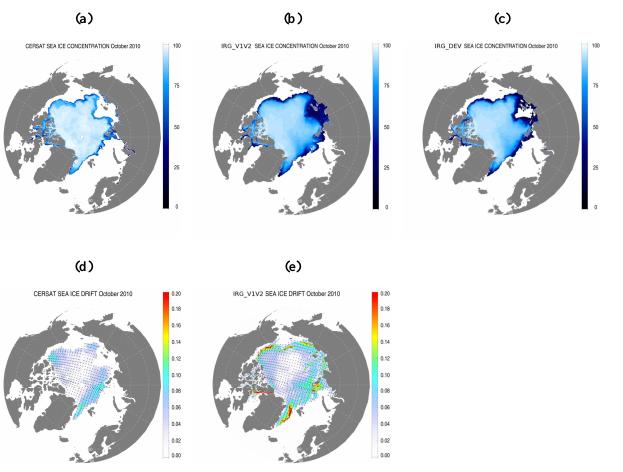
Fig. 13. Sea ice extent (10 6 km 2 ) in the Arctic (upper panel) Fig. 13. Sea-ice extent (10 6 km 2 ) in the Arctic (upper panel) and the Antarctic (lower panel) 3 and the Antarctic (lower panel) for the 2007–2011 period, from for the 2007-2011 period, from SSMI satellite measurements (red line) from IRG_V1V2 (blue 4 SSM/I satellite measurements (red line), IRG V1V2 (blue line) and line) and IRG_DEV (black line). 5 IRG DEV (black